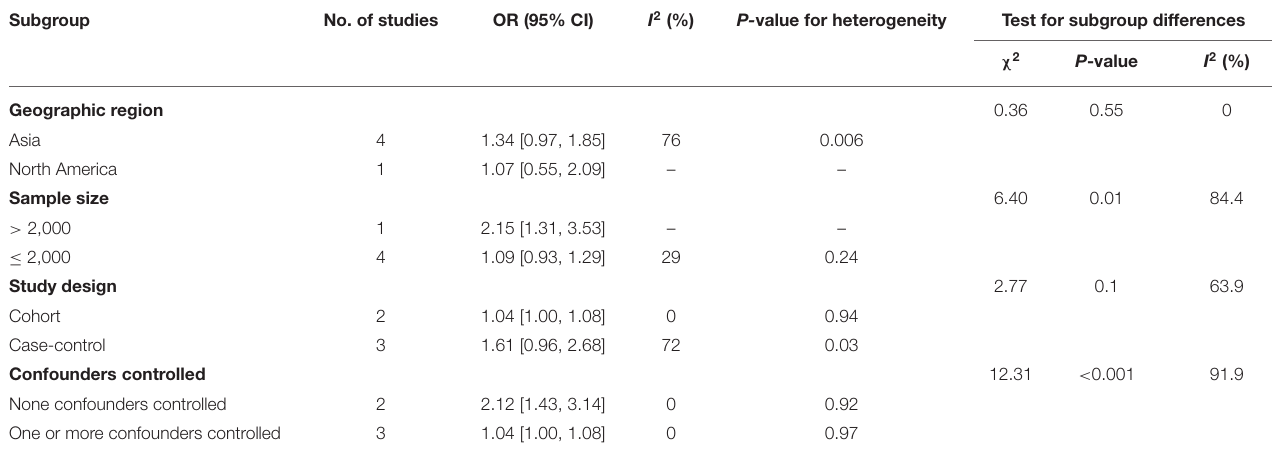
TABLE 6 | Subgroup analyses for the association between childhood overweight/obesity and early puberty in boys.